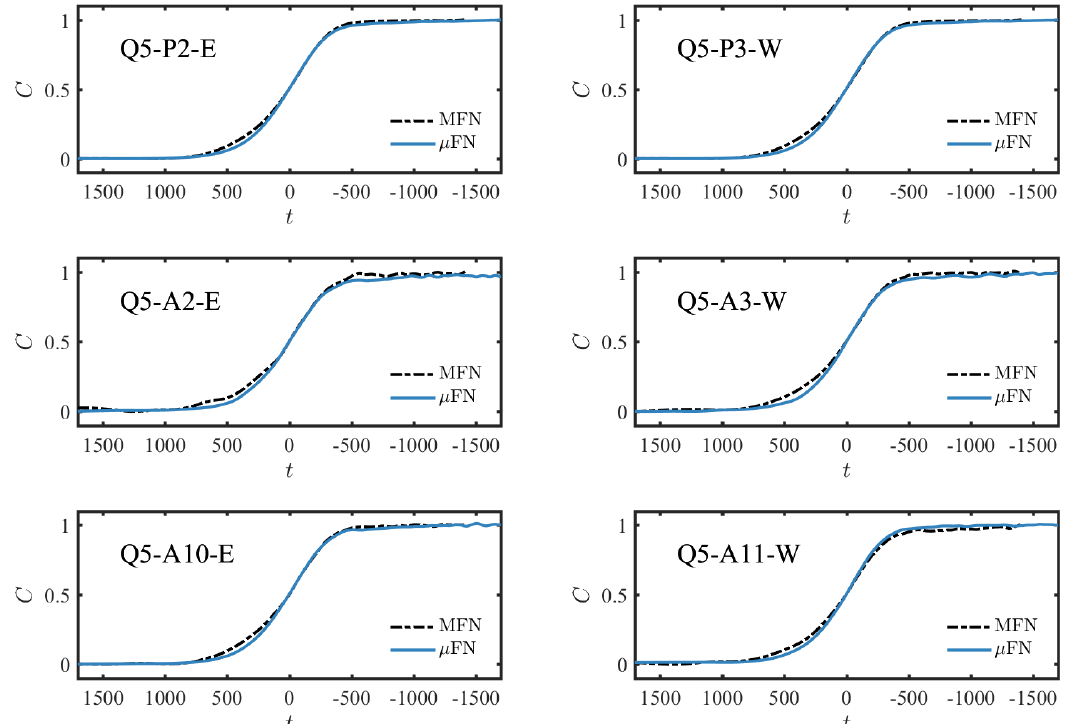
Figure A4. Measured breakthrough curves in the MFN (dashed line) and µ FN (solid line) at upstream (east) and downstream (west) locations on the same primary (P2–P3), secondary (A10–A11) and tertiary (A2–A3) fracture at Q = 5 µ L/h.